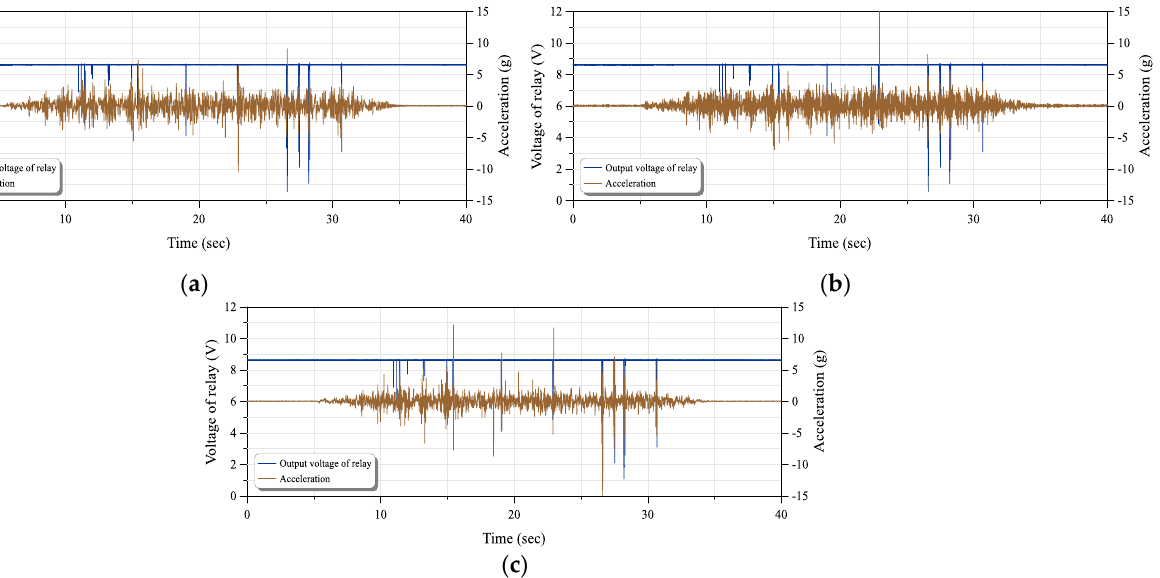
Figure 15. Comparison of relay chatter and acceleration response during CRS (PGA 0.75 g): ( a ) side to side, ( b ) front to back, and ( c ) vertical.